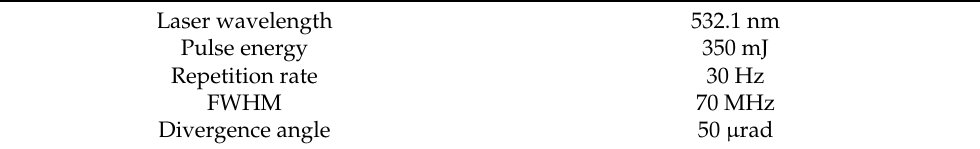
Table 1. Transmitter parameters.